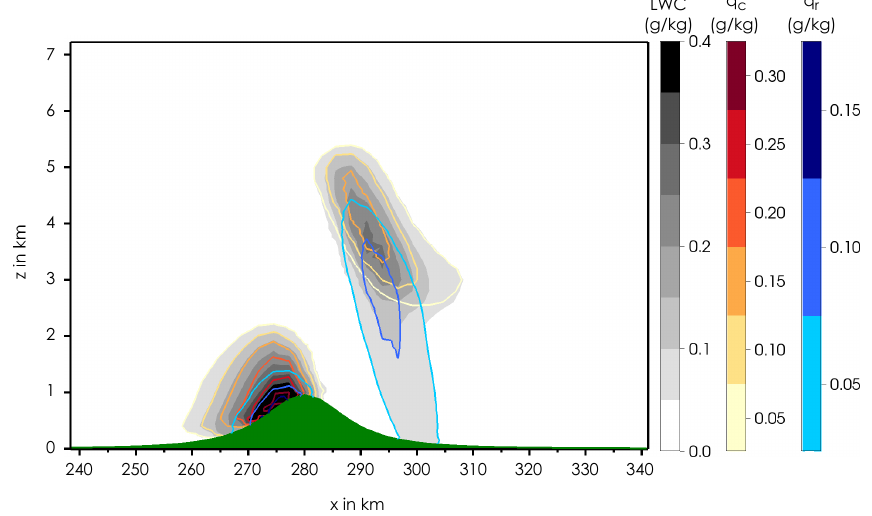
Figure 19. Vertical cross section ( x – z plane) of microphysical properties for the RH95 case. Liquid water content (shaded), contours of specific cloud water content q c (red–yellow) and specific rain water content q r (blue).